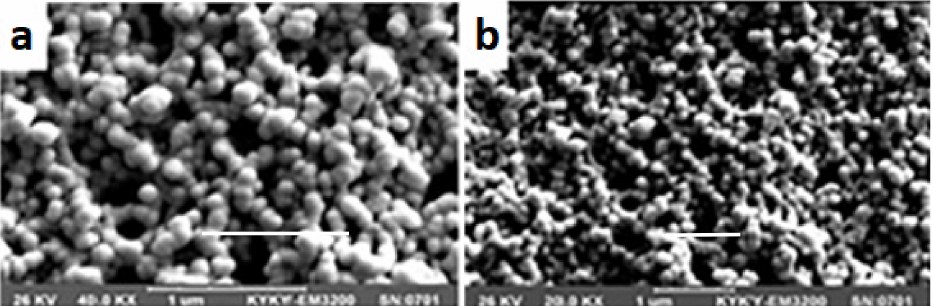
Figure 8. SEM micrographs of chitosan coated calcium-alginate nanocapsules fresh sample immedi- ately after preparation ( a ); resuspended dried sample ( b ). Adapted with permission from ref. [55]. 2021, Taylor &